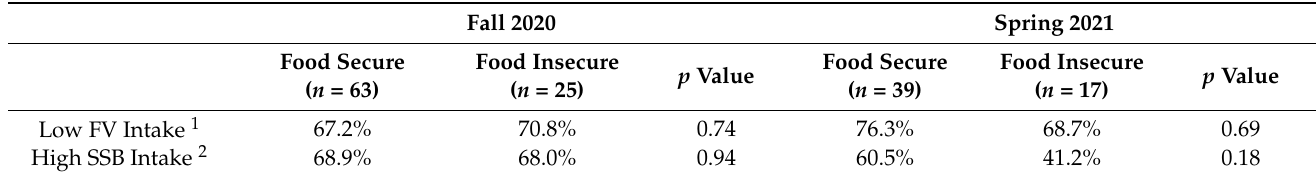
Table 2. SSB and FV Intake by food security status.